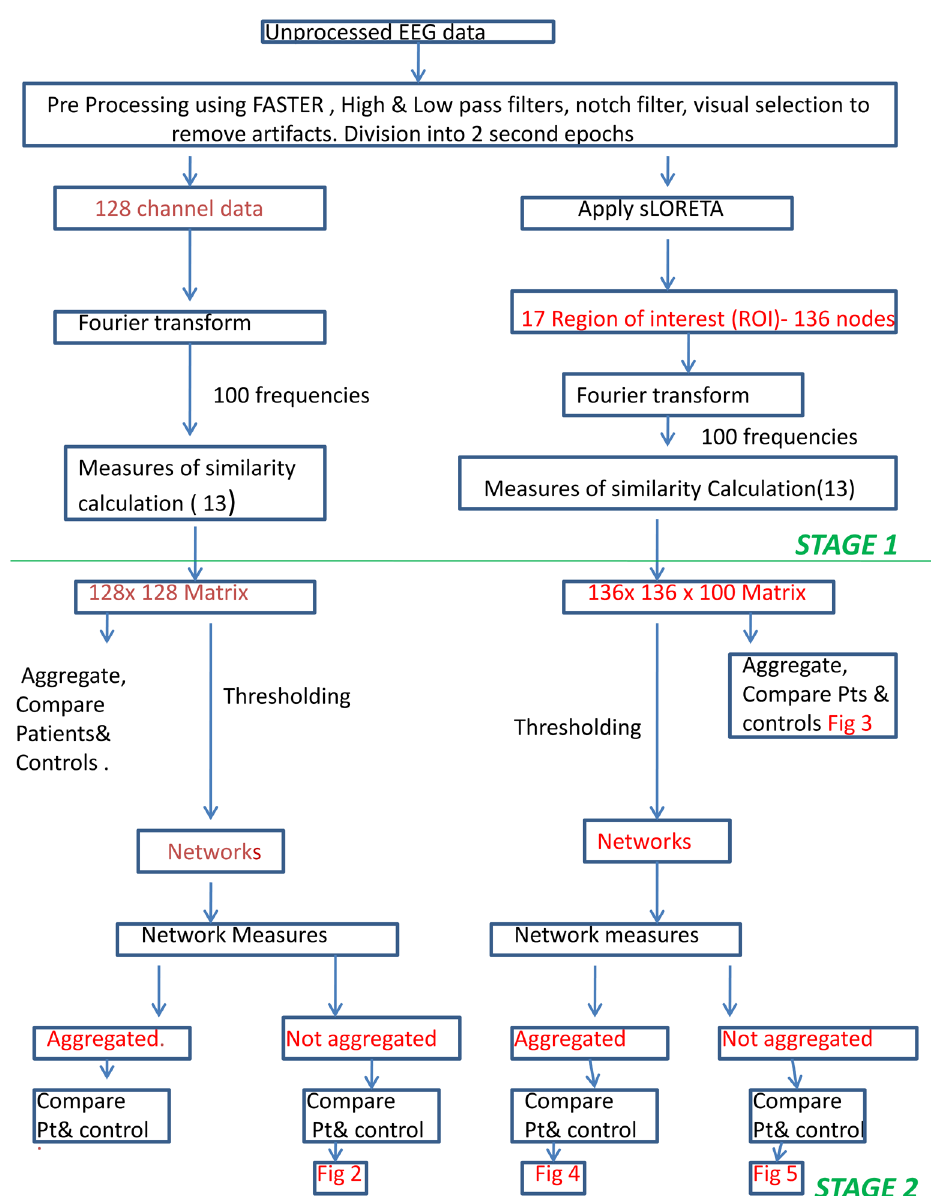
Fig 1. Methods Flow Chart. Flowchart of methods explaining the preprocessing and two stage processing for scalp connectivity and nodal connectivity.